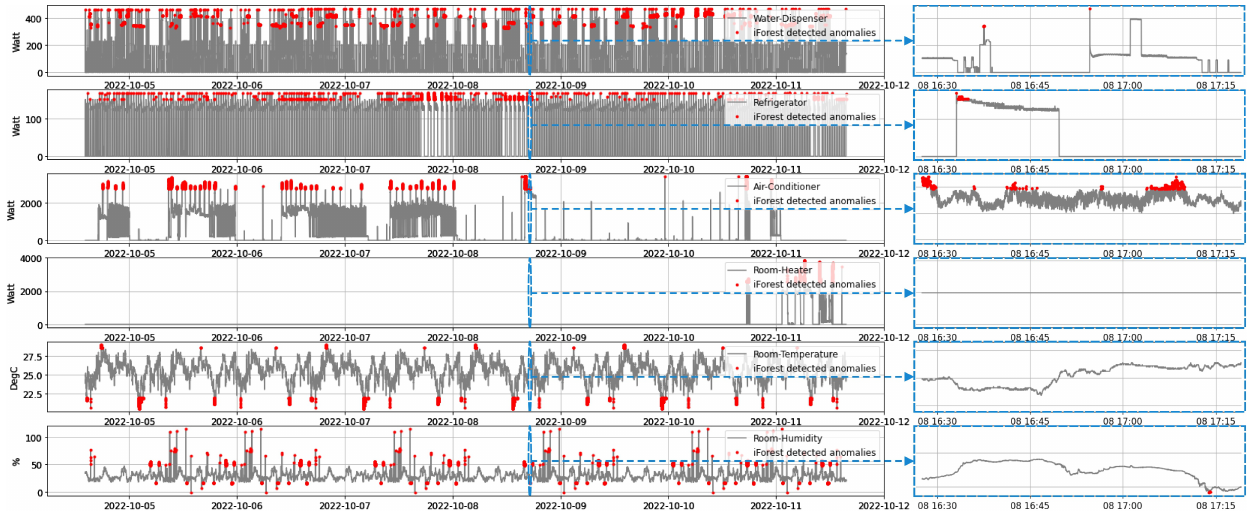
Figure 15. Anomalies found in the heterogeneous data of a house during training phase. Table 4. Outlier detection observation during the learning phase of isolation forest